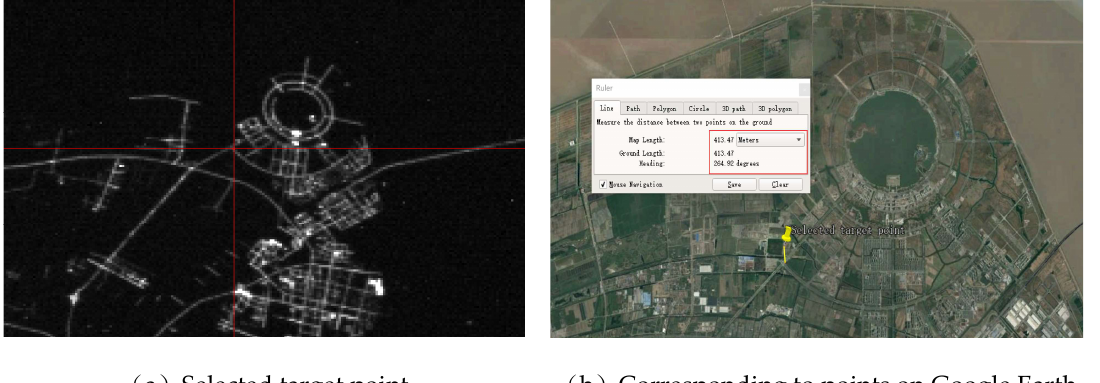
Figure 10. Examples of uncontrolled orientation accuracy assessment.